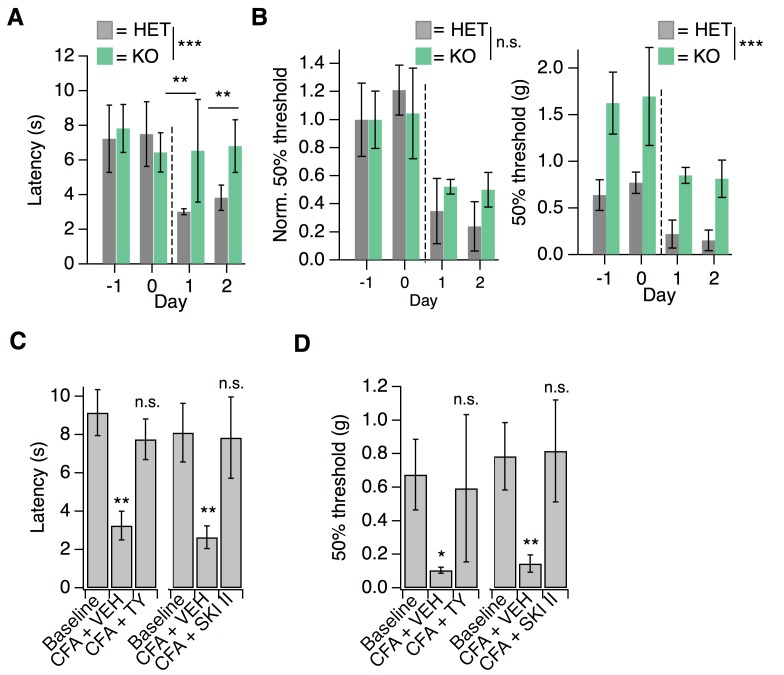
S1PR3 is dispensable for development of chronic mechanical hypersensitivity.(A) Thermal latency before and after CFA treatment (indicated by dotted line); pgenotype = 0.0053 (two-way ANOVA; N = 5 mice per genotype). Sidak’s multiple comparison between genotypes for specific time points indicated on graph. Error bars represent mean ± SD. (B) (Left) Normalized 50% withdrawal threshold before and after CFA treatment (indicated by dotted line); p(genotype)<0.001 (two-way ANOVA). (Right) 50% withdrawal thresholds for same experiment (p(genotype)=0.1634; two-way ANOVA). (C) (Left) Thermal latency assessed before (‘Baseline’) and 24 hr post CFA injection with either vehicle (CFA + VEH) or TY 52156 (CFA + TY) acutely administered; p<0.0001 (one-way ANOVA N = 5 mice per treatment). (Right) Thermal latency assessed before and after CFA injection with either vehicle (CFA + VEH) or SKI II (CFA + SKI II) acutely administered on Day 1; p<0.0001 (one-way ANOVA; N = 5–7 mice per treatment). Dunnett’s test comparisons to baseline are indicated on graph. Error bars represent mean ± SD. (D) (Left) 50% withdrawal threshold assessed before and 24 hr post CFA injection with either vehicle (CFA + VEH) or TY 52156 (CFA + TY) acutely administered on Day 1; p<0.0001 (one-way ANOVA; N = 5 mice per treatment). Dunnett’s test comparisons to baseline are indicated on graph. (Right) 50% withdrawal threshold assessed before and 24 hr post CFA injection with either vehicle (CFA + VEH) or SKI II (CFA + SKI II) acutely administered; p-values indicated on graph (two-tailed unpaired t-test; N = 5 mice per group.10.7554/eLife.33285.018Figure 7—source data 1.S1PR3 is dispensable for development of chronic mechanical hypersensitivity.Related to Figure 7.